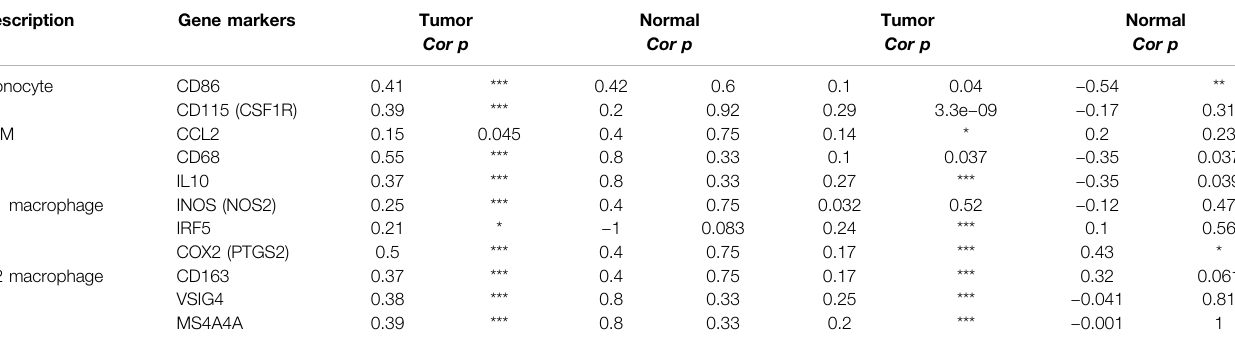
TABLE 3 | Correlations between YAP1 expression and markers of monocytes and macrophages in GEPIA Description Gene markers PAAD STAD. Description Gene